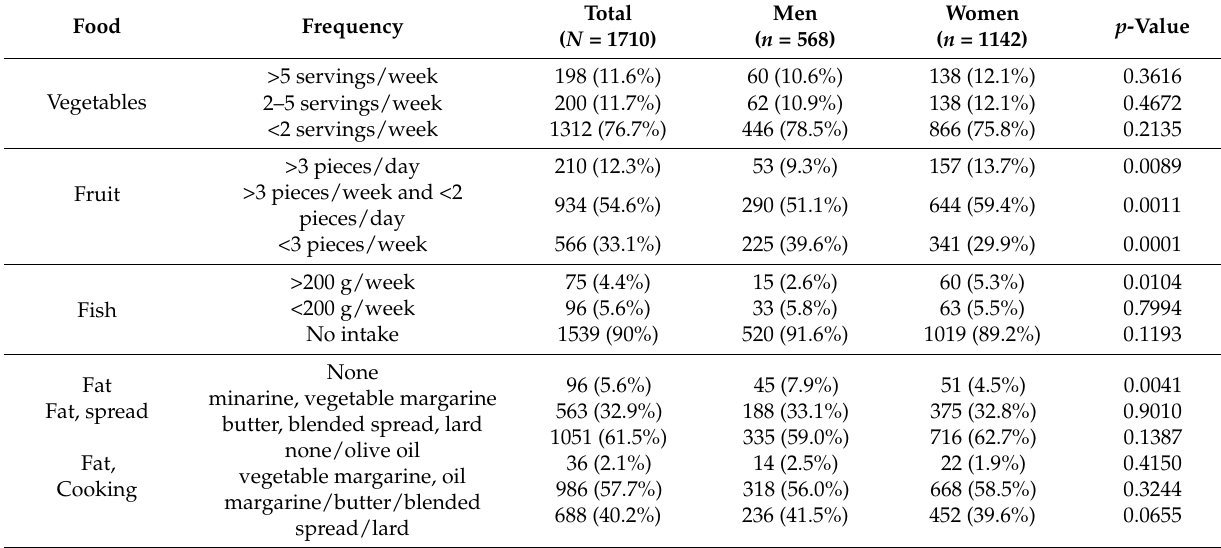
Table 5. Frequency of consumption of the most important food ingredients in the study sample N = 1710.